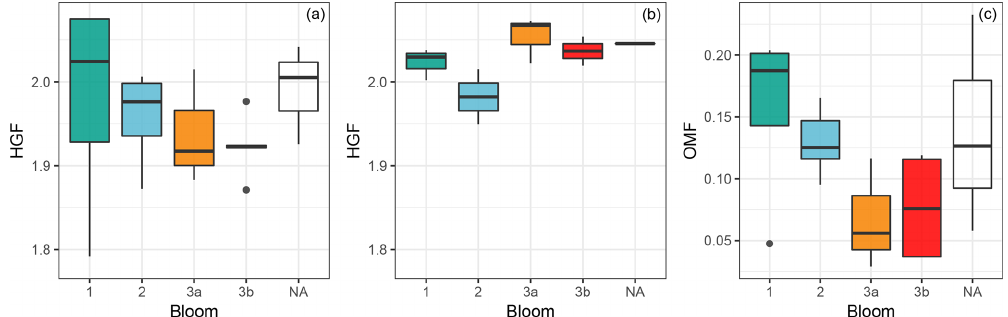
Figure 8. Ambient HGF (a) , heated HGF (b) and PM 1 OMF (c) by bloom. HGFs measured using VH-TDMA, OMF measured from FTIR and IBA analysis of filter samples. Note that NA refers to measurements taken outside of an identified bloom.